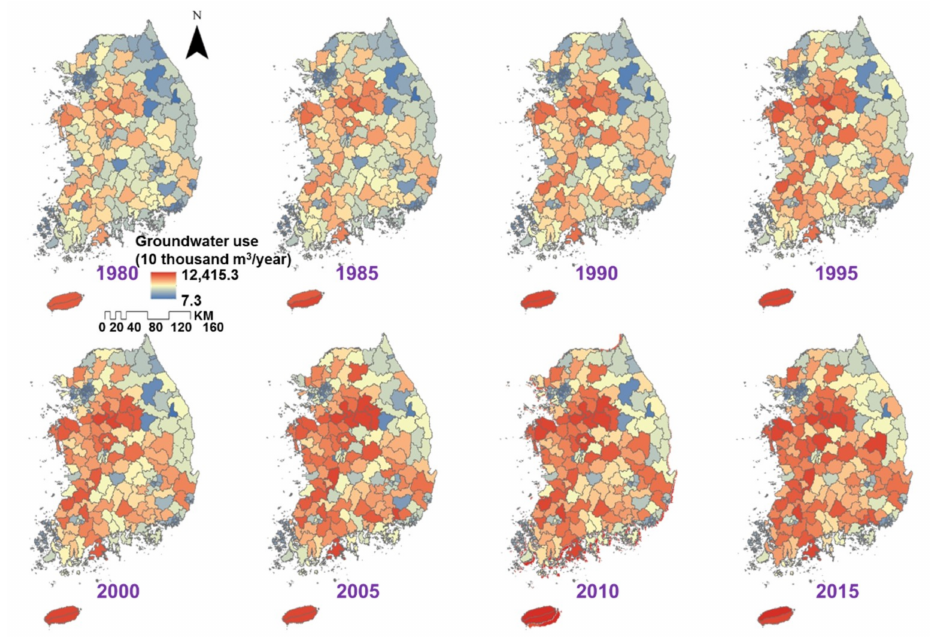
Figure A1. Distribution map of groundwater use (GWU) for different regions from 1980 to 2015 in the study area in five-year